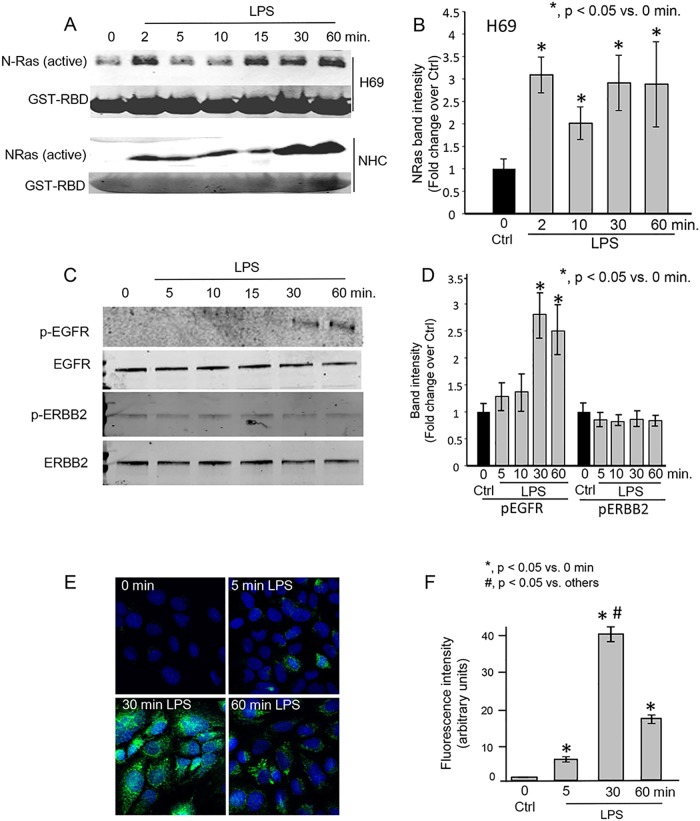
LPS induces NRas activation in cultured human cholangiocytes.A. Confluent NHC and H69 cells were treated with LPS for 0, 2, 5, 10, 15, 30, and 60 minutes. LPS induced rapid and persistent NRas activation. B. Quantitation of NRas intensity. NRas band intensity was normalized to GST-RBD Ponceau red band intensity and is presented as fold change over the 0 time point +/- SEM from three independent experiments. C. Western blots for phospho-EGFR (pEGFR), total EGFR, phospho—ERBB2 (pERBB2), and total ERBB2 were also performed on lysates from the LPS-treated H69 cells. Phospho-EGFR was detected 30 and 60 minutes post-LPS treatment. D. Quantitation of pEGFR and pERBB2. Band intensity was normalized to total EGFR or ERBB2, respectively, and is presented as fold change over 0 time point control. E. Confocal immunofluorescence microscopy detected a progressive increase in phospho-EGFR following LPS treatment of H69 cells. F. Semi-quantitation of fluorescence intensity demonstrates an increase of phospho-EGFR fluorescence through the 30 minute time point. Data is presented as mean +/- SEM from three independent experiments and >100 cells per experiment.